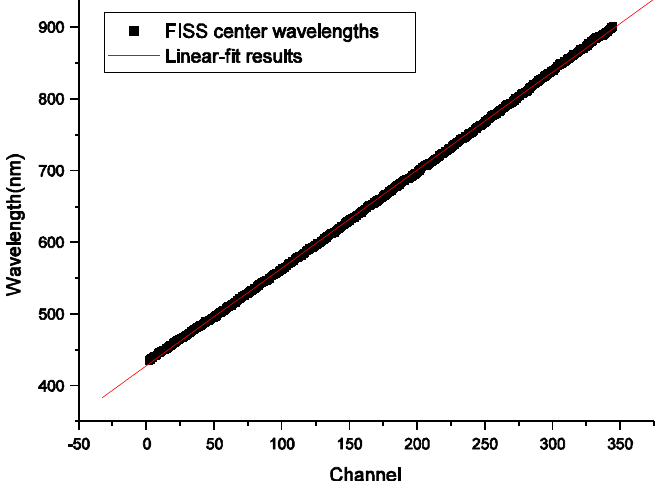
from (3) for all 344 channels, 1